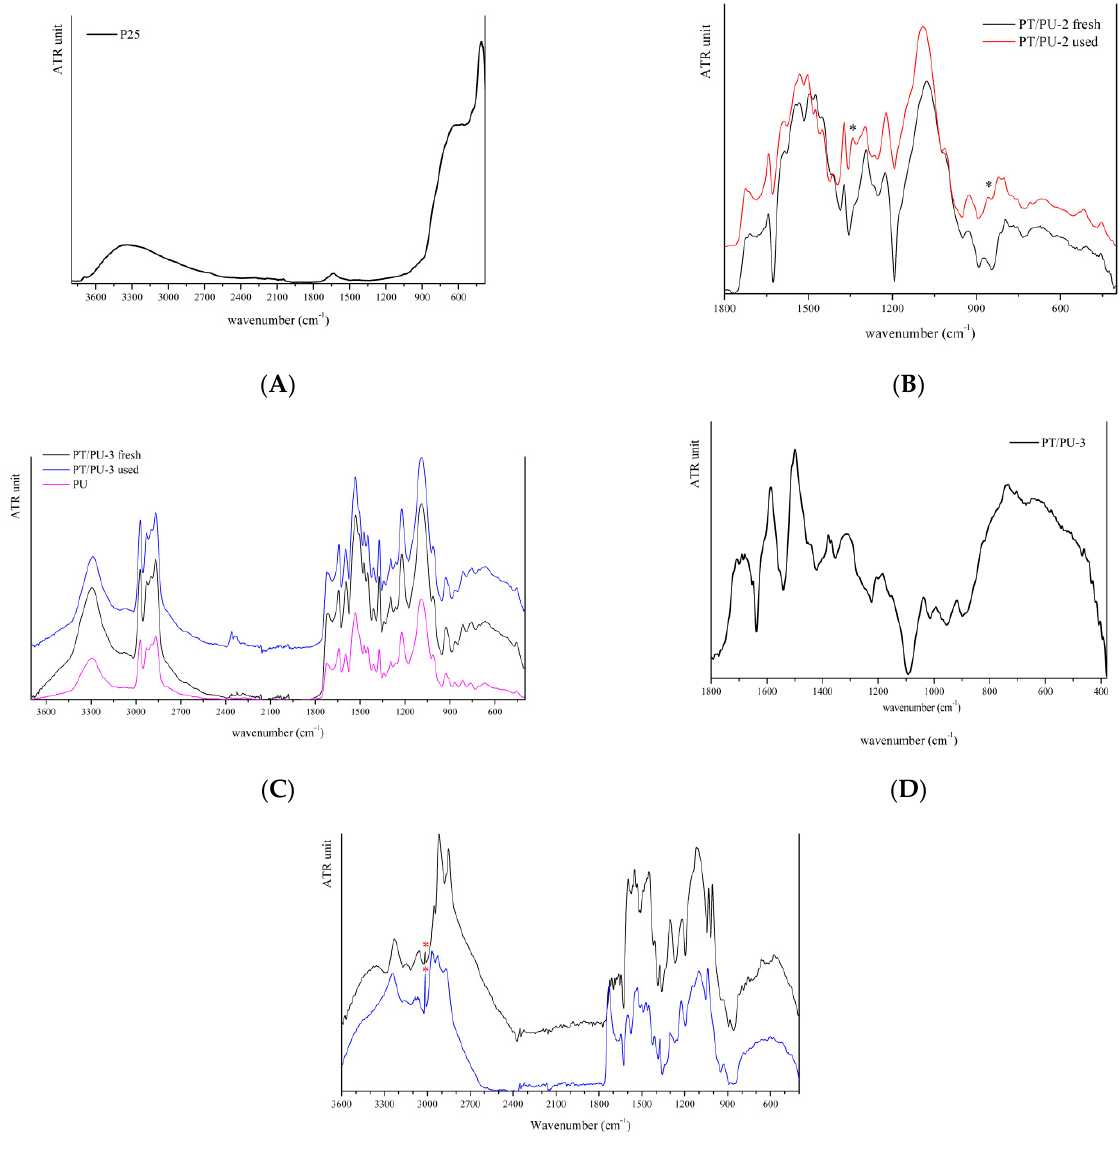
Figure 1. ATRFTIR spectra of ( A ) TiO 2 powder, ( B ) fresh and used PT/PU-2, ( C ) fresh and used PT/PU-3, ( D ) PT/PU-3 differential spectrum, ( E ) PT/PU-4 and -5.